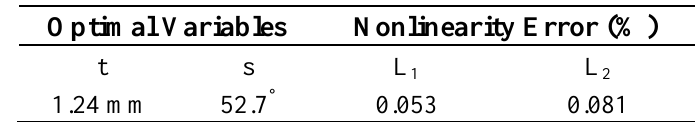
Table 9. Optimal variables for nonlinearity